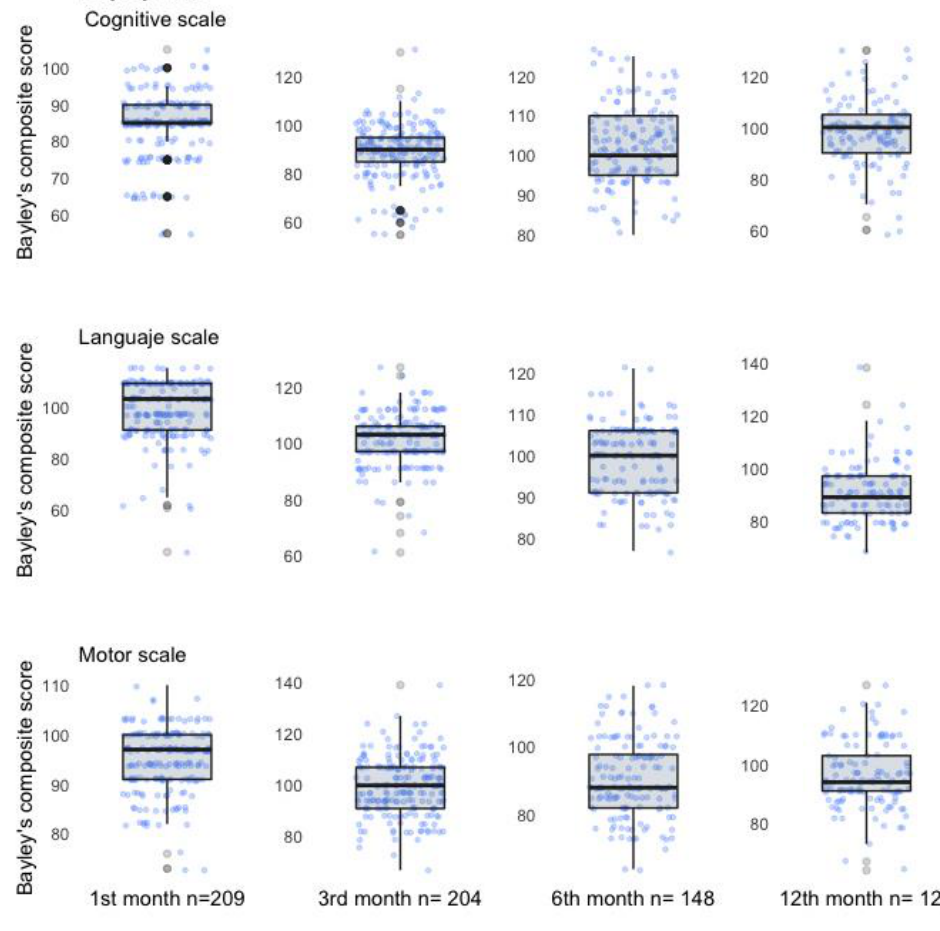
Figure 2. Bayley Scale III. Scores subscales by age. Table 2. Neurodevelopment association with prenatal blood lead, mercury, and manganese levels